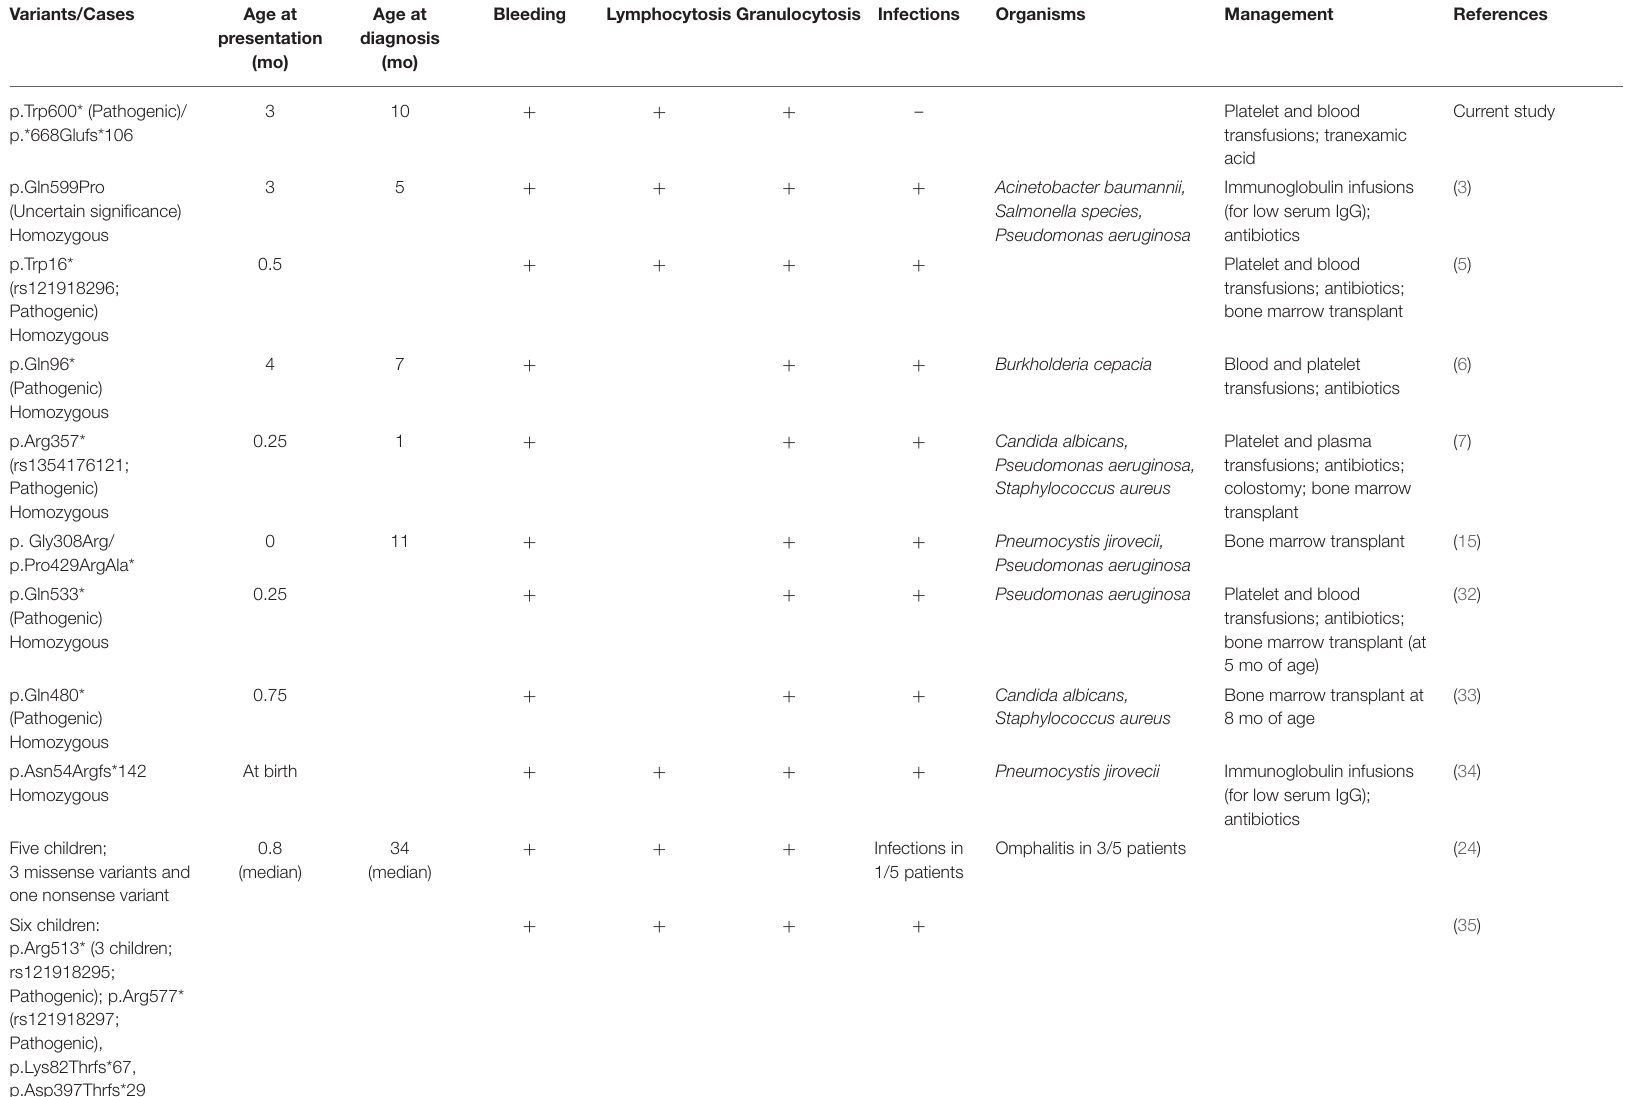
TABLE 3 | Natural histories of the current and previously reported FERMT3 (Ensemble transcript: ENST00000279227.5) variants.